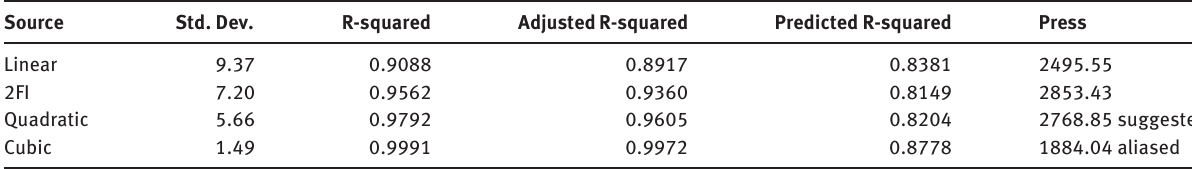
Table 3: Model summary statistics.